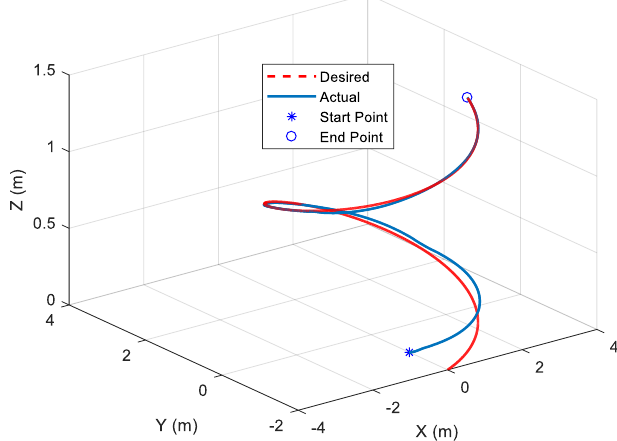
Figure 5. Tracking response of Figure 3 case with the robust asymptotical tracking control [26].